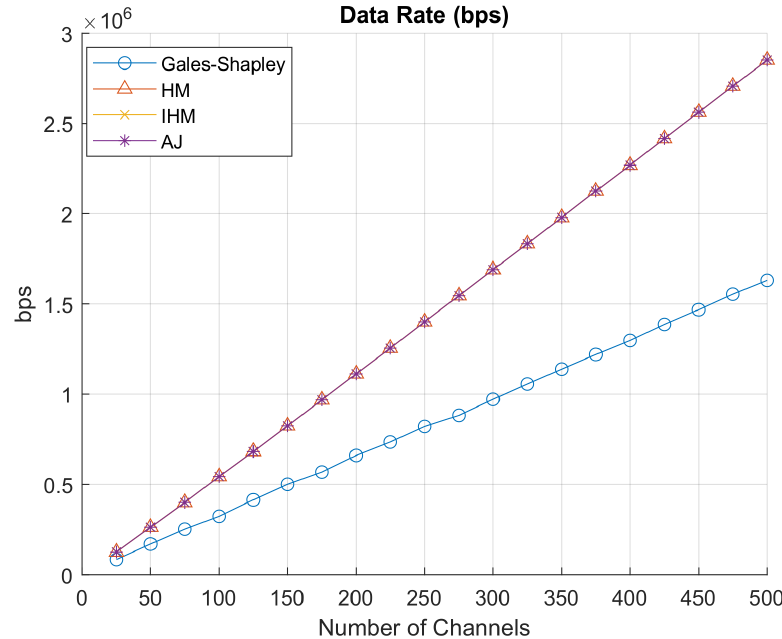
Figure 7. Net datarate.